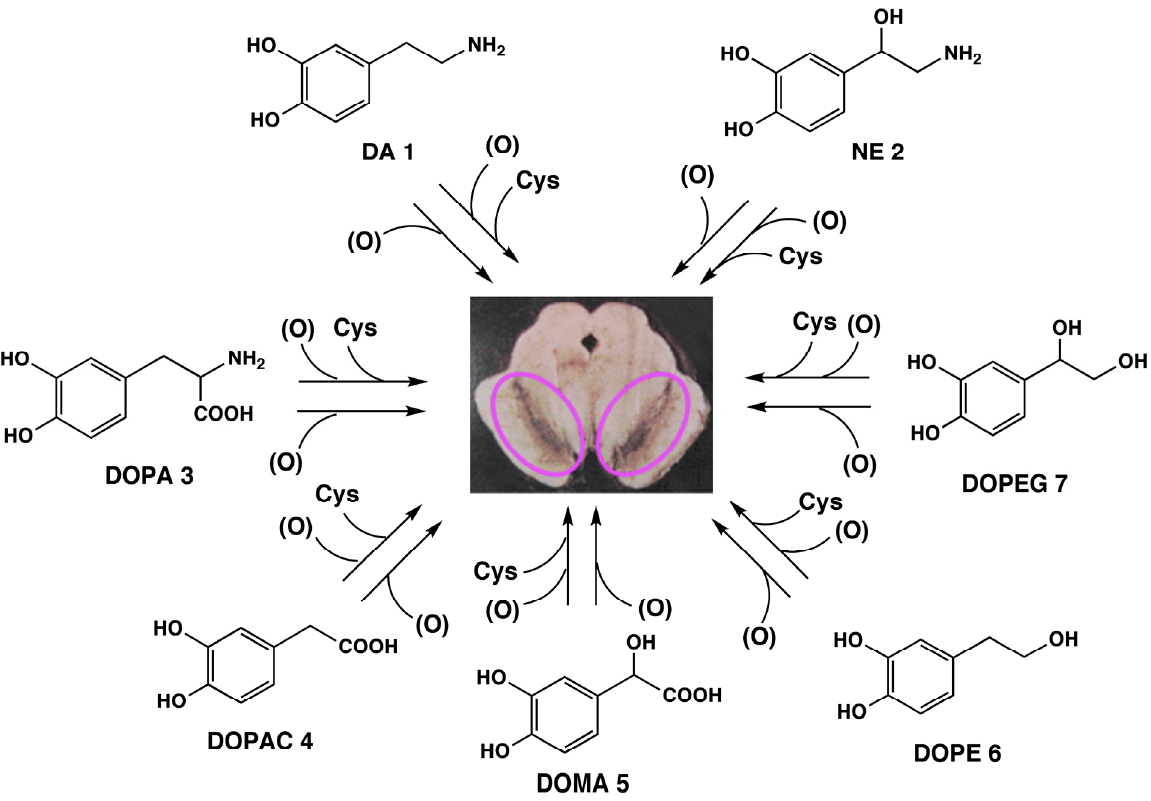
Scheme 1. Possible participation in NM biosynthesis of various catecholic metabolites known to be present in various brain regions of the human brain. Purple circles depict NM accumulation in neurons of the SN. (O) represents